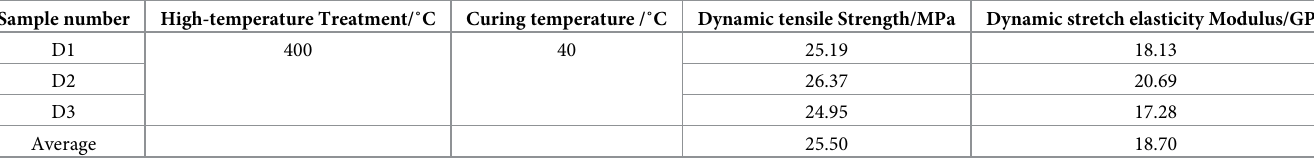
Table 2. Test results of the failure criterion